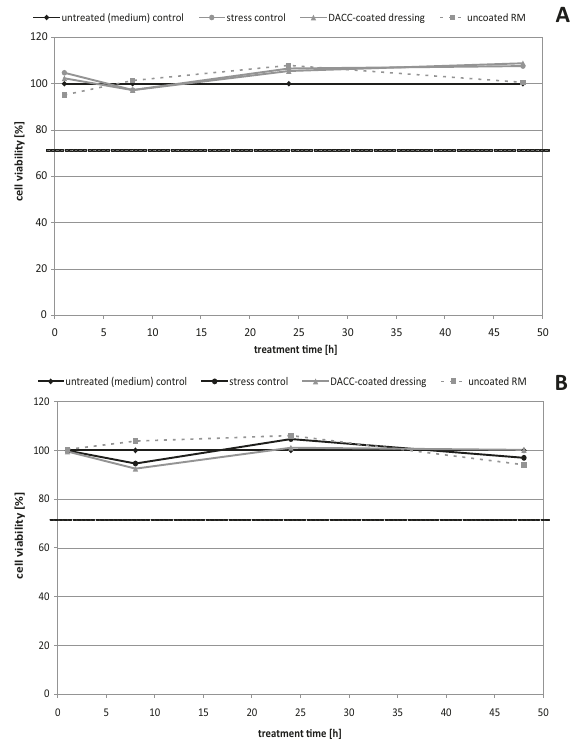
Fig. 1 Determination of the in fl uence of the stress control, DACC- coated dressing, and uncoated RM on HaCaT cell viability ( A ) and NHDF viability ( B ) compared to the untreated (medium) control using the MTT test